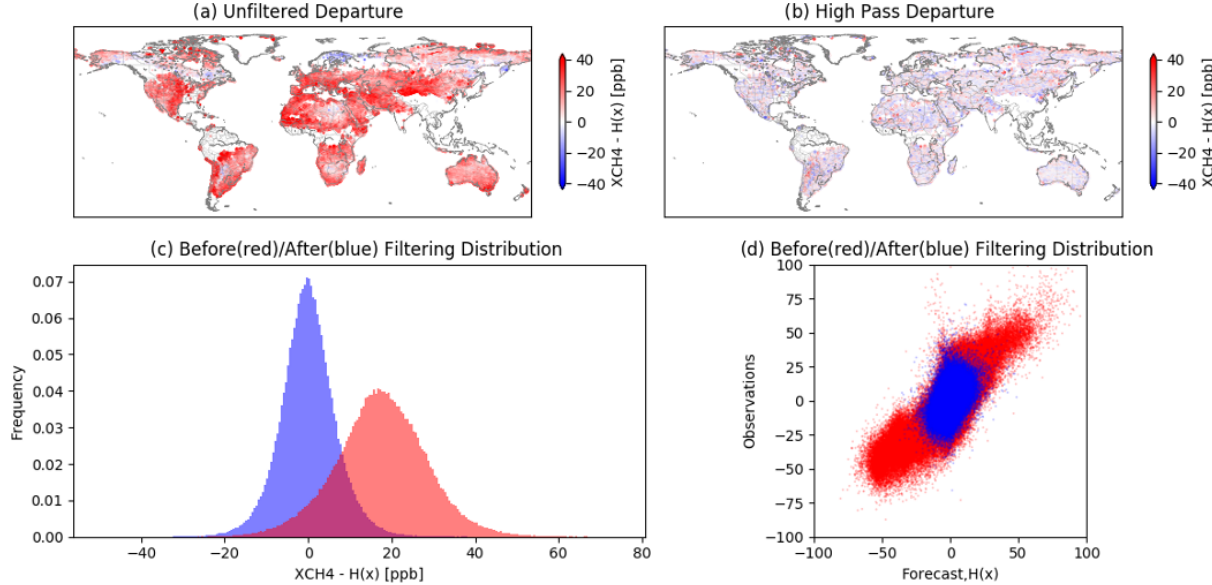
Figure 7. Example of the effect of high-pass filtering on observation-space data using a 30d window ending on 1 July 2019 with a 2 ◦ Gaussian kernel length scale: (a) the unfiltered departures, (b) the filtered departures, (c) histograms comparing unfiltered (red) vs. filtered (blue) departures, and (d) 2D distributions of the unfiltered (red) and filtered (blue) data points in the observation–forecast space. Note that the unfiltered data distribution is centred at the mean in this plot to facilitate comparisons with the filtered